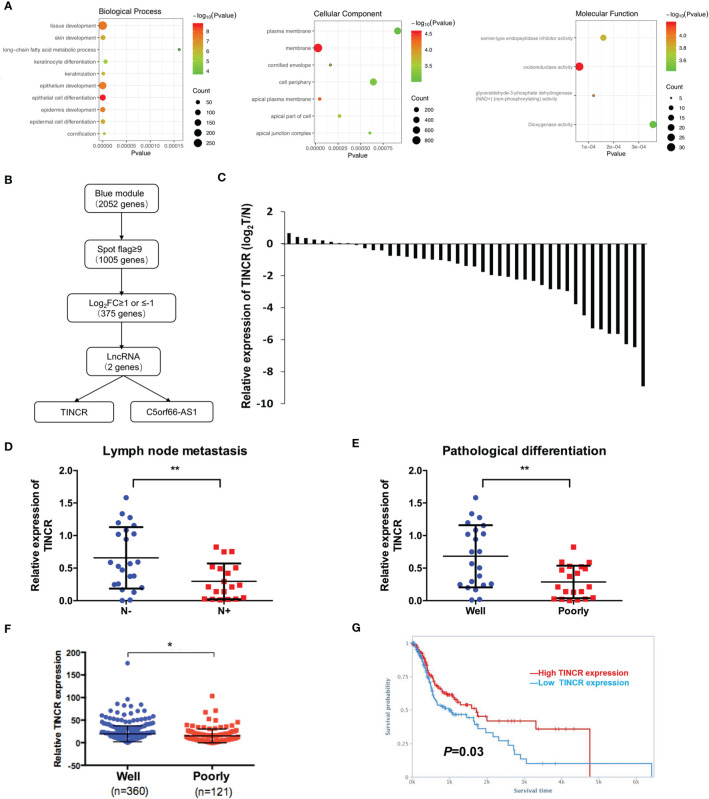
TINCR was downregulated in OSCC tissues. (A) Enrichment of the gene ontology (GO) terms of mRNAs in the blue module. (B) A workflow of lncRNA screening. (C) The expression of TINCR in OSCC tissues and non-cancerous adjacent tissues (NATs) was shown by qRT-PCR. qRT-qPCR analysis of TINCR expression in OSCC samples grouped by the lymph node metastasis (D) and the pathological differentiation (E). (F) Analysis of TINCR expression in HNSCC samples from the TCGA database, and the HNSCC samples were grouped by the pathological differentiation. (G) Kaplan-Meier analysis from TANRIC database based on the HNSCC patient cohort of TCGA showed that the high TINCR expression group had a higher survival rate than the low TINCR expression group. *P < 0.05, **P < 0.01.